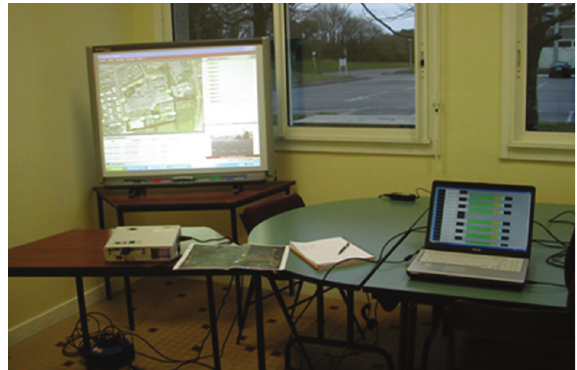
Figure 3: Photo of the supervisor of the sensor network deployed in